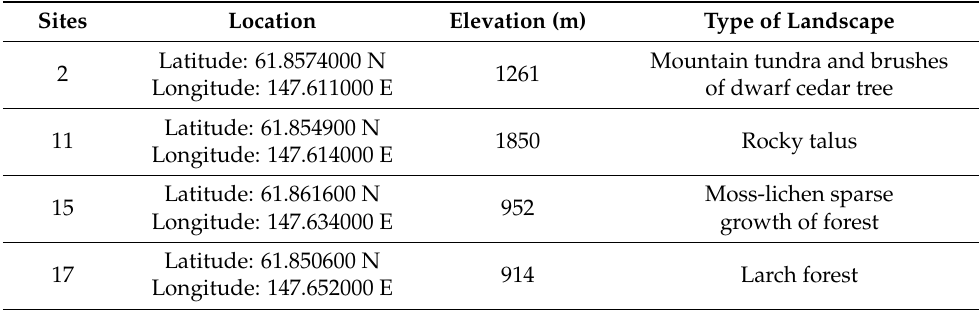
Table 3. Regional characteristics of the sites.